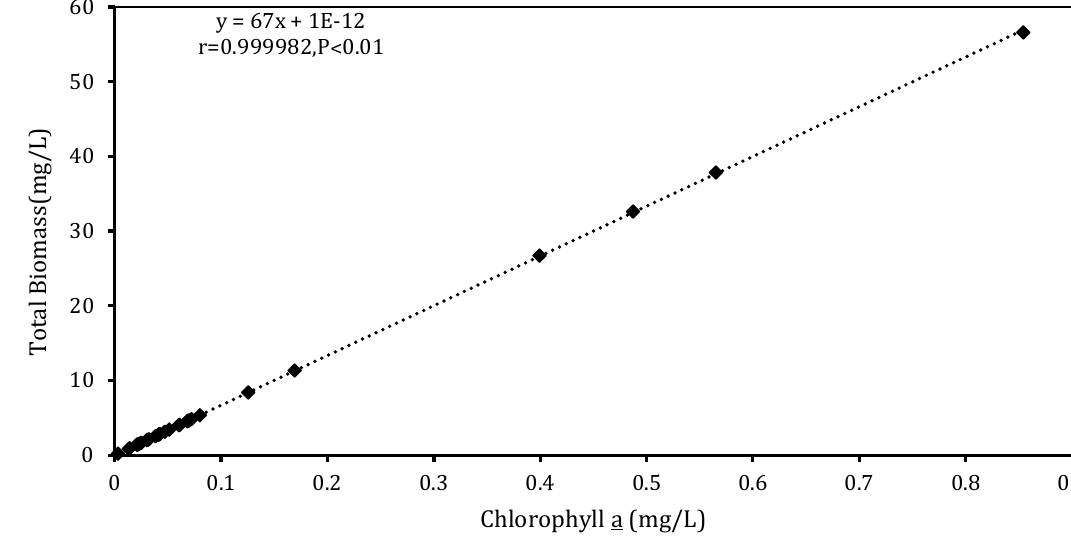
Figure 6: Correlation coefficient (r) of total biomass (mg/L) of S. platensis with chlorophyll a (mg/L) of spirulina grown in supernatant of three digested DRMM and